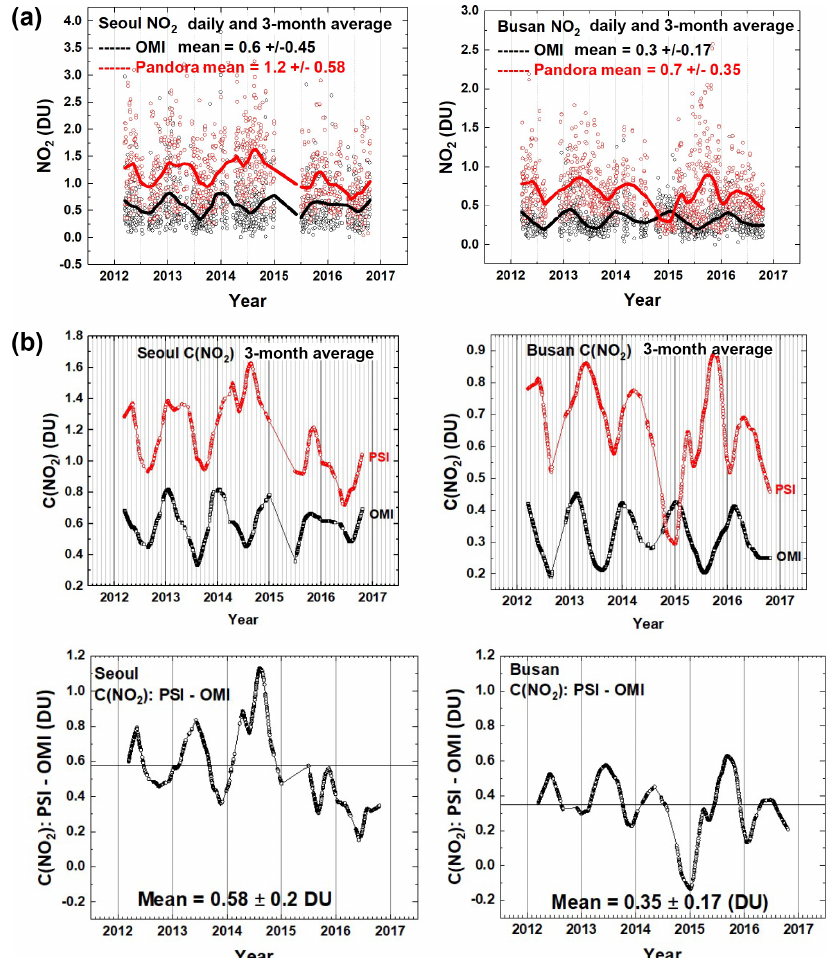
Figure 9. (a) Comparisons between the daily values of C ( NO 2 ) for OMI (black) and PSI (red) at Seoul and Busan for a 5-year period. Solid lines show the average seasonal variation (Lowess(0.1)), see also panel (b) . Linear interpolation is used where there are missing data points. (b) Comparisons between the seasonal averages for C ( NO 2 ) from OMI (black) and PSI (red) at Seoul and Busan for a 5-year period. The lower panels show the seasonal difference between the PSI and OMI. The individual data points are shown derived from a Lowess(0.1) smoothing, approximately a 3-month running averages of the daily data. Interpolation has been used where there are missing data points.